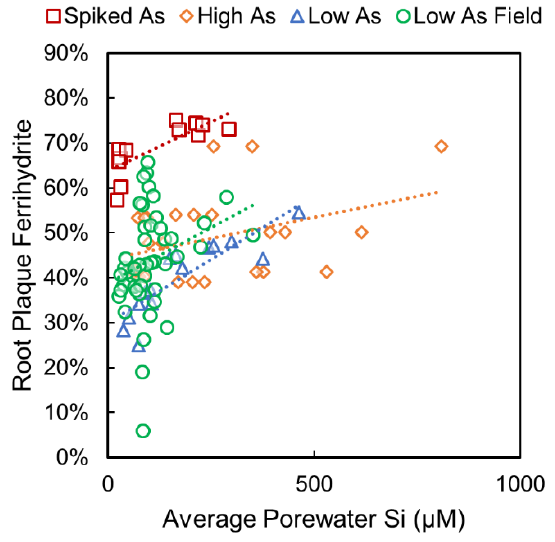
Figure 3. Positive relation between average porewater Si concentration and the fraction of ferrihydrite in the root plaques in all tested pot and field experiments. (Spiked As: R 2 = 0.61, p = 0.0026, n = 12; High As: R 2 = 0.15, p = 0.046, n = 27; Low As: R 2 = 0.74, p < 0.0001, n = 15; Low As Field: R 2 = 0.078, p = 0.057, n = 47).